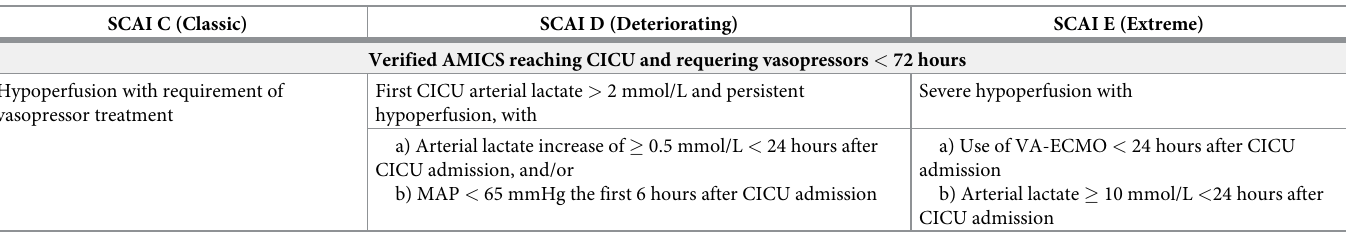
Table 1. Modified SCAI class